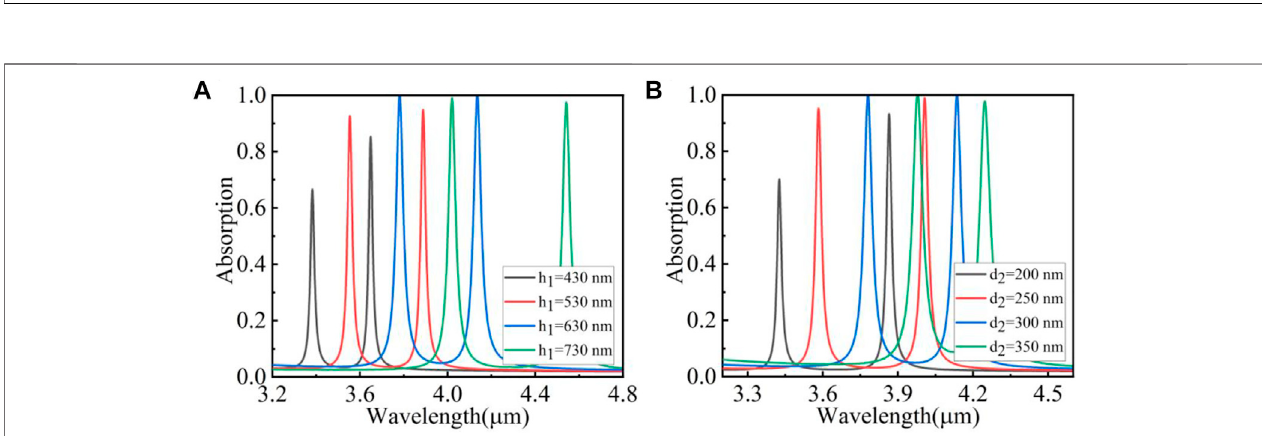
FIGURE 5 | (A) The effect of changing the thickness of the grating silicon on the absorption spectrum. (B) The effect of changing the silicon width of the grating on the absorption spectrum.